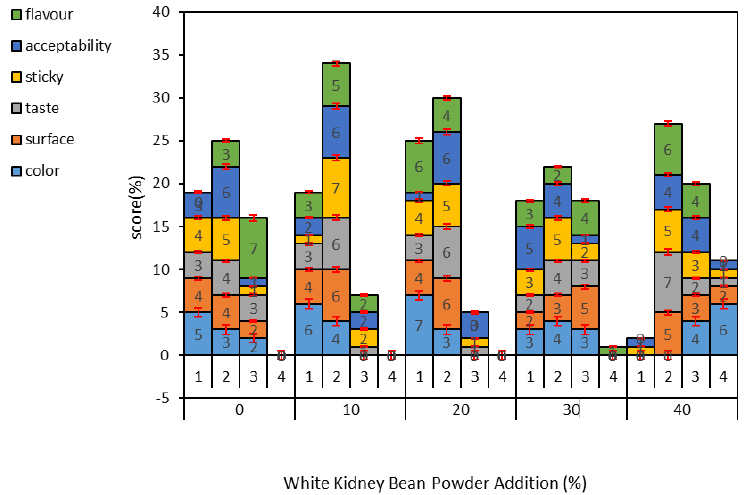
Figure 2. Sensory evaluation of noodles: 1–4 for represent excellent, good, pass, or fail, respectively; 0–40% represents white kidney bean flour addition.